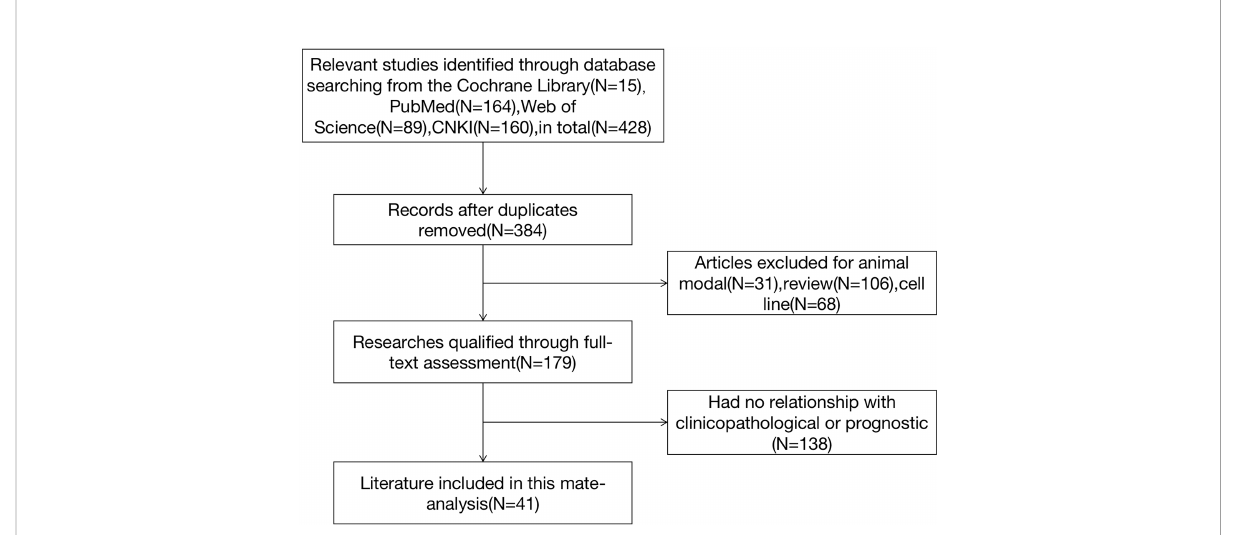
FIGURE 1 Flow diagram of the study selection process for inclusion in the